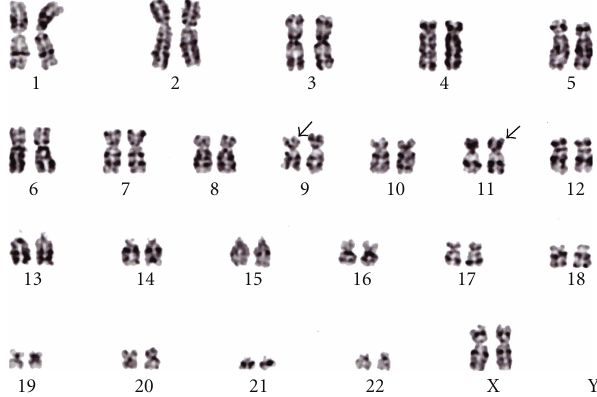
Figure 1: Karyotype analysis showed t(9;11)(p22;q23). At the time of diagnosis, bone marrow cells were analyzed by commercially available service (BML laboratory, Japan). Twenty of the 20 metaphases cells disclosed t(9;11)(p22;q23) in G-banding